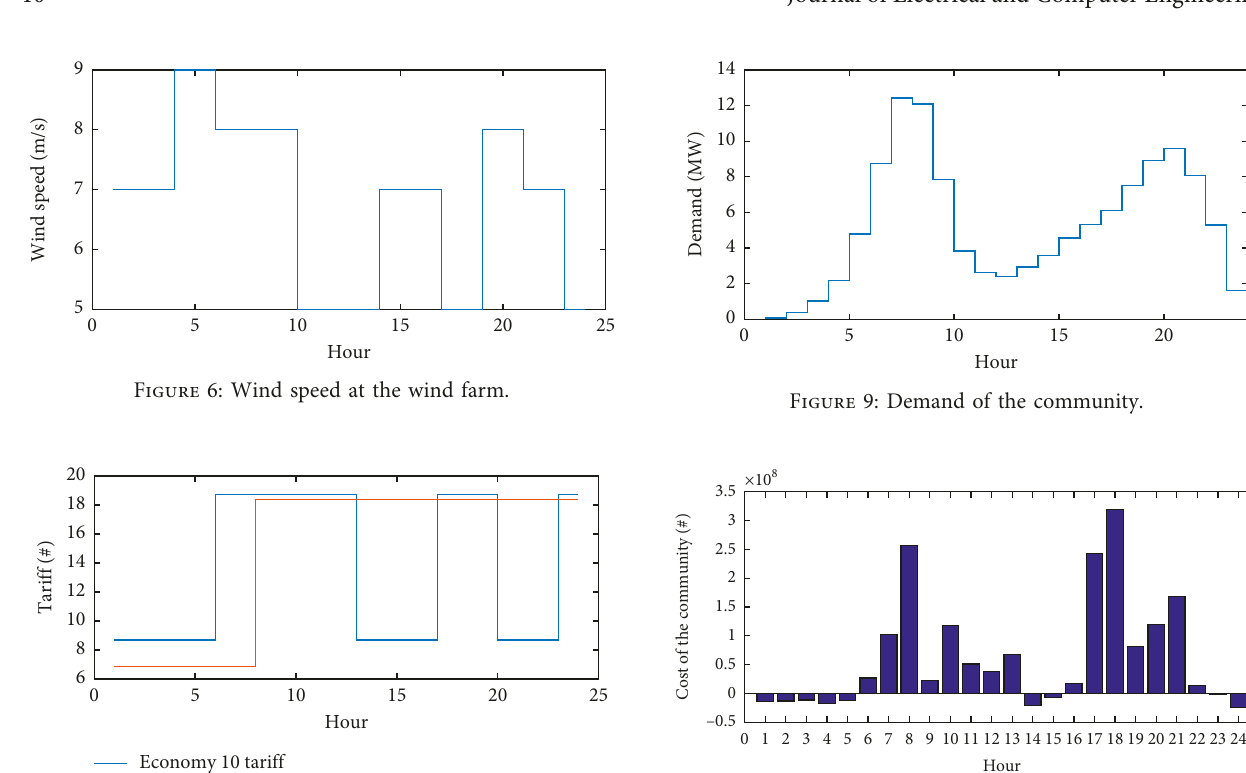
Figure 10: Cost of the community at each hour for the base case.